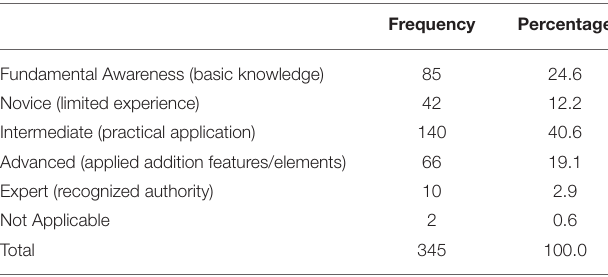
TABLE 5 | The rate of USIM student skills in e-Learning.